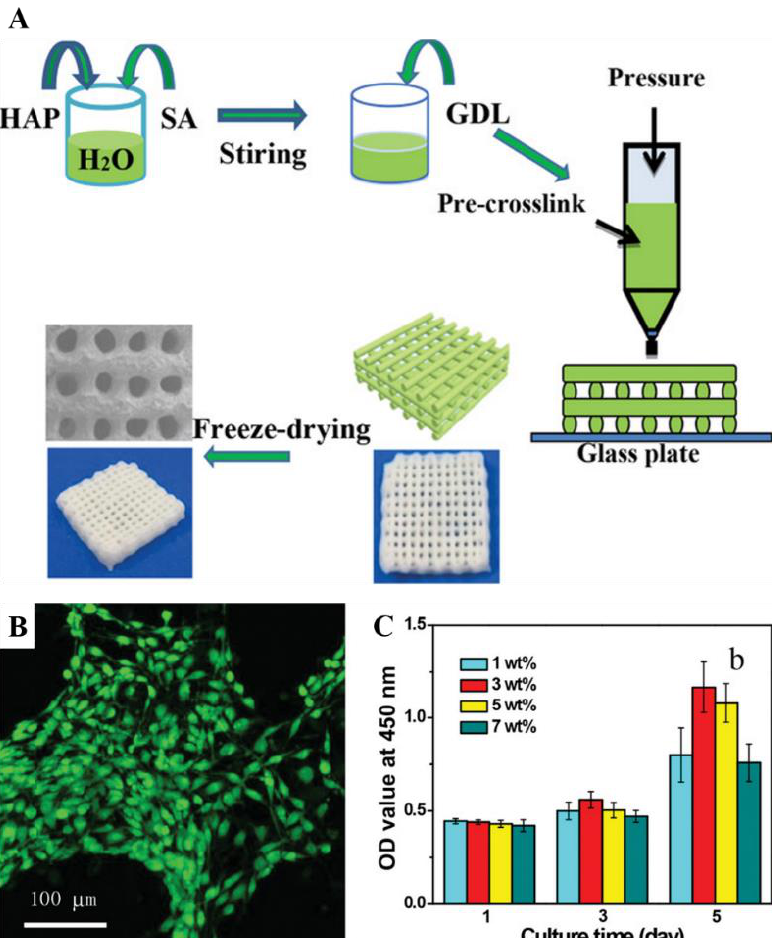
Figure 2. ( A ) Schematic illustration of the 3D printing of hydrogels based on sodium alginate and hydroxyapatite (SA/HAP). In this case, alginate and hydroxyapatite were solubilized in water and extensively mixed together. Glucono-delta-lactone (GDL), a controlled acidifying agent able to promote partial calcium release from hydroxyapatite, was then added to the alginate mixture (pre- crosslinking). The resulting mixture was then extruded. The progressive calcium release was able to promote the gelation of alginate, and thus the formation of hybrid hydrogels based on alginate and hydroxyapatite. These hydrogels were freeze-dried obtaining scaffolds. ( B ) Confocal Laser Scanning Microscopy (CLSM) micrographs of fluorophore labelled Bone Marrow Stem Cells (BMSCs) after 5 days of culture on the same scaffolds; ( C ) BMSCs proliferation at different timeframes (1, 3, and 5 days of culture) on the porous scaffolds with different HAP amount. Reproduced with permission from Bioactive and Biocompatible Macroporous Scaffolds with Tunable Performances Prepared Based on 3D Printing of the Pre-Crosslinked Sodium Alginate/Hydroxyapatite Hydrogel Ink by S. Liu et al., 2019, Macromolecular Materials and Engineering, 304 (4), 11 (doi:10.1002/mame.201800698). Copyright 2019 by John Wiley and